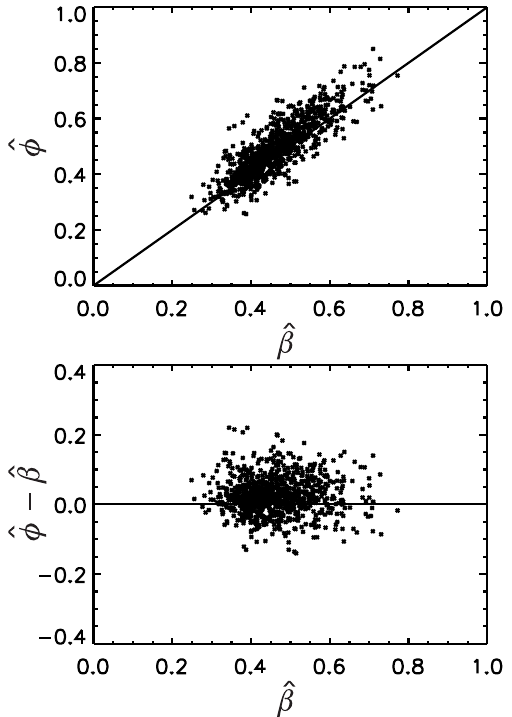
Fig. 7. Histograms for β and φ for RSNs with parameter values p i = 0 . 345 and p e = 0 .